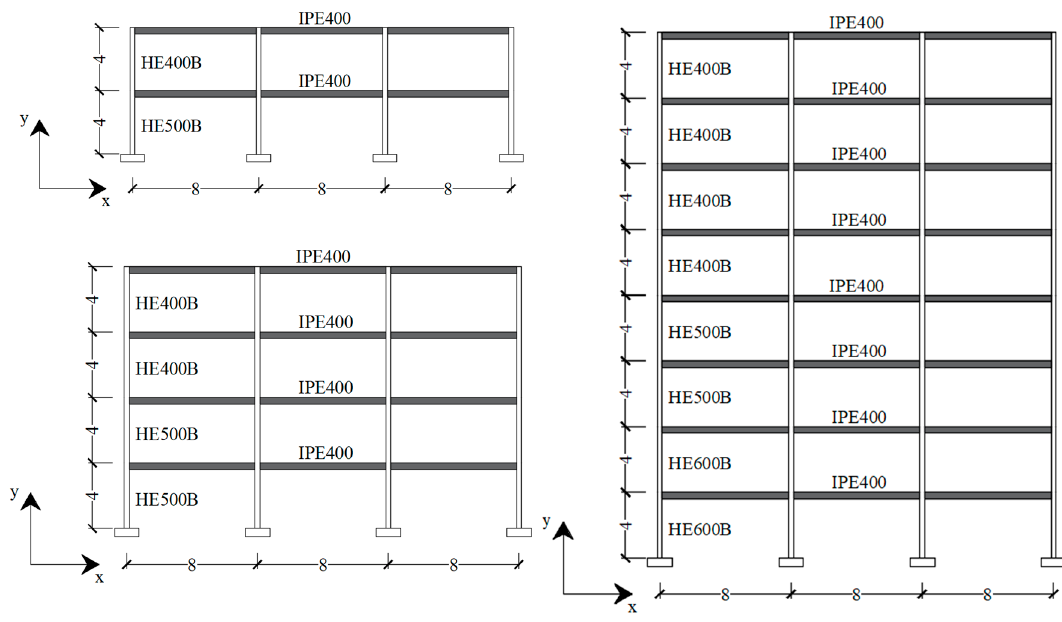
Figure 1. Typical plan of the three case-study structures (dimensions in m).